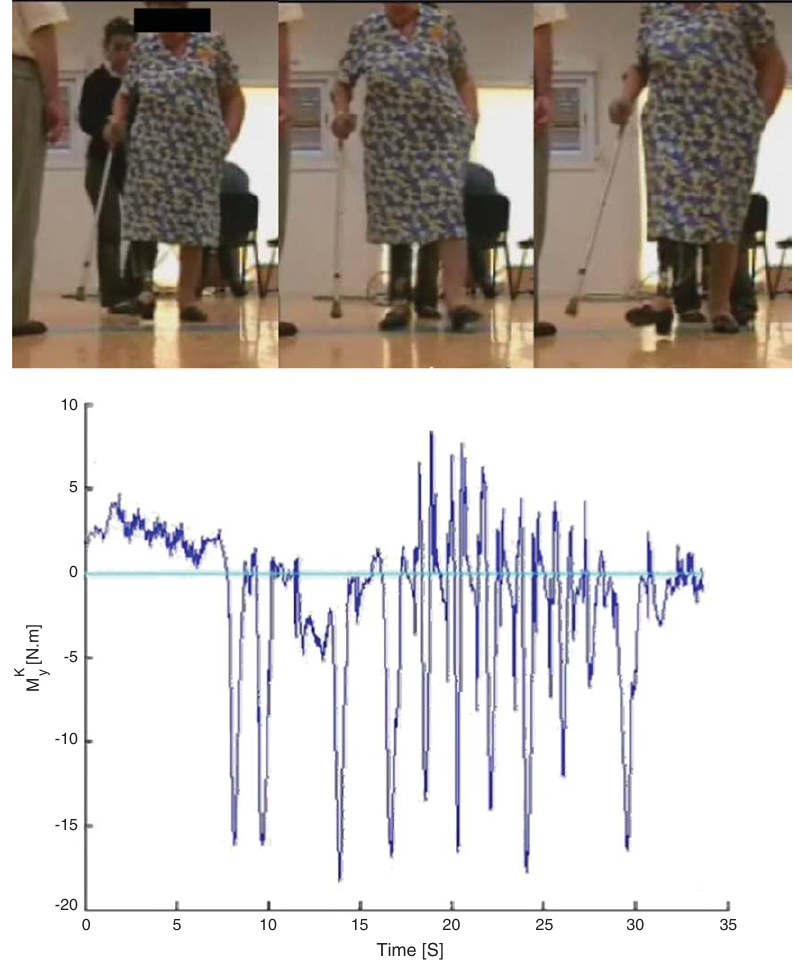
Fig. 13. Walking task performed by an amputee patient wearing our prosthesis. Top: Pictures from video recording, Bottom: Knee moment evolution. From this point, a PC controlled the knee joint using the detection